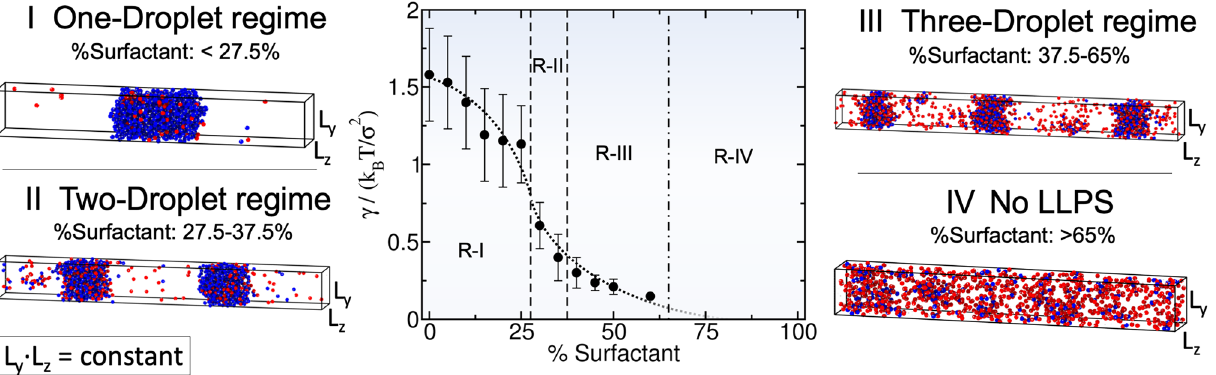
Figure 3. Surface tension ( γ ) dependence on the scaffold–surfactant composition (in % ) at T ∗ / T ∗ c = 0.75 and system (global) density of ρ ∗ = 0.136 . Vertical dashed lines indicate the maximum surfactant concentration which allows LLPS for a given number-droplet regime in our system. Note that the maximum droplet size varies continuously with surfactant concentration even within the same number-droplet regime. The maximum condensate size in terms of surface/volume ratio along the different number-droplet regimes are: ∼ 0.11 σ − 1 for the one-droplet regime, ∼ 0.19 σ − 1 for the two-droplet regime, and ∼ 0.27 σ − 1 for the three-droplet regime. At surfactant client compositions exceeding 65 % there is no LLPS. For each computed composition, the global density of the system and the simulation box cross-section ( L z L y ) are kept constant. Snapshots of the DC simulations along different surfactant composition droplet regimes are included. Please note that in the multidroplet regime, the different coexisting droplets (at the same surfactant concentration) exhibit similar compositions and densities.